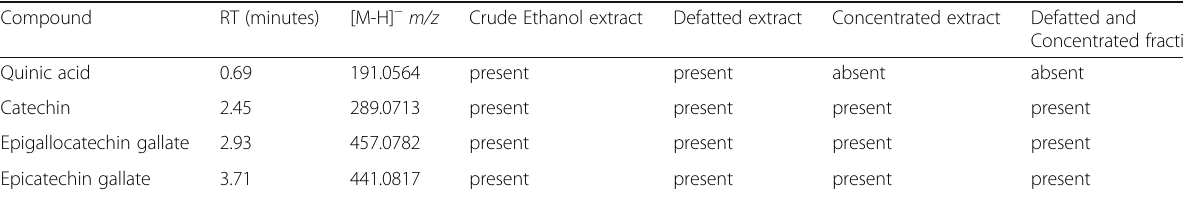
Table 4 A comparison of major compounds identified in Marula extracts